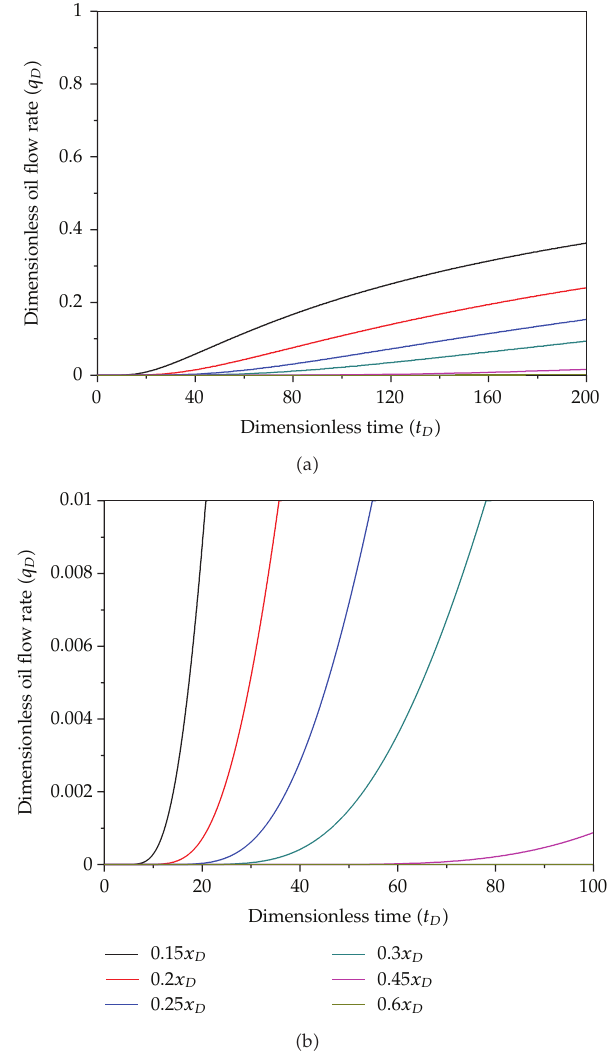
Figure 5: Results from dynamic simulation of the relationship of q D versus t D in di ff erent x D (cid:2) The selected x D is far away from the upper limit temperature (cid:3)